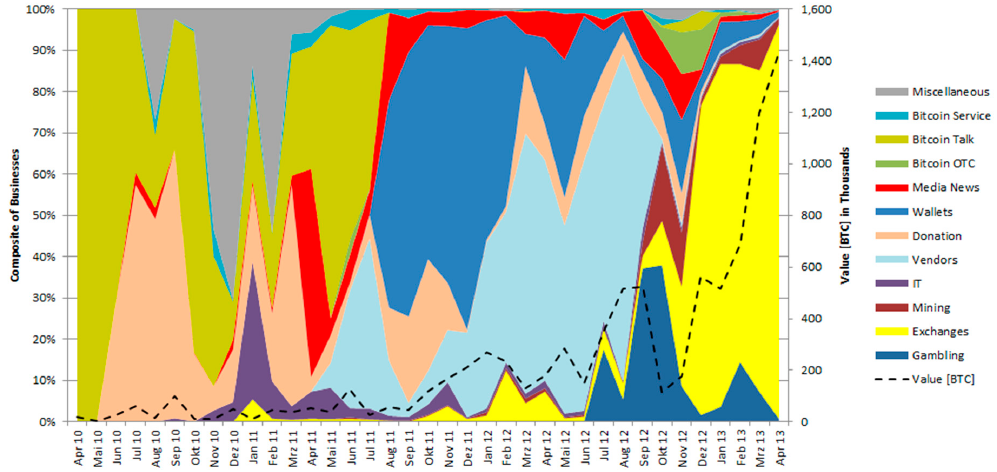
Figure 11. Composite of Businesses over Time (Value in BTC).